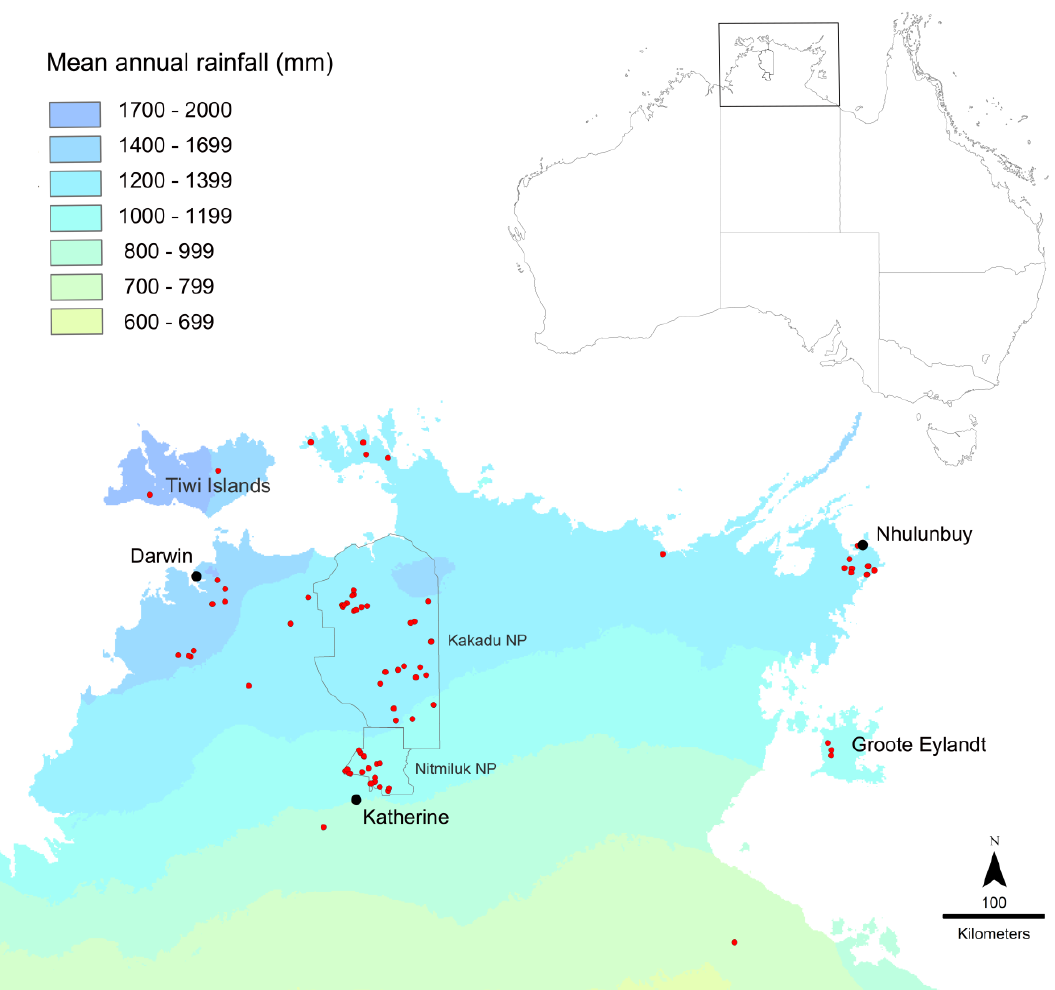
Figure 5. Map of collection localities in the Top End of the Northern Territory. Collection localities for sequenced specimens are shown in red. Collections are heavily concentrated in Kakadu and Nitmiluk National Parks, as indicated.